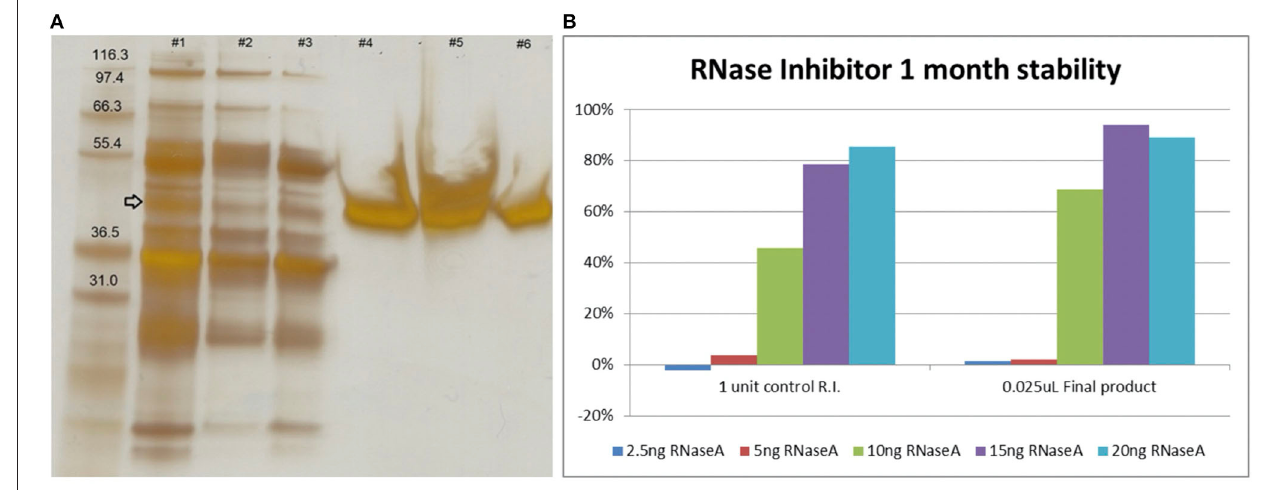
FIGURE 9 | Quality control assay for RNase inhibitor, silver staining ( ∼ 2 µ g protein per lane) of SDS-PAGE gel (A) and RNase inhibitor assay (showing % activity of RnaseA) of final product 1 month after purification (B) . Lane 1: 1st re-suspended isoelectric precipitate with arrow indicating possible RNase inhibitor. Lane 2: 2nd re-suspended isoelectric precipitate. Lane 3: post-Sepharose binding sample. Possibly not all RNase inhibitor was captured. Lane 4: main peak of elution fraction 10–15. Lane 5: tail of elution (fraction 16–30). Lane 6: final product concentrated from the main fractions. Commercial RNase Inhibitor (Roche) was used as a